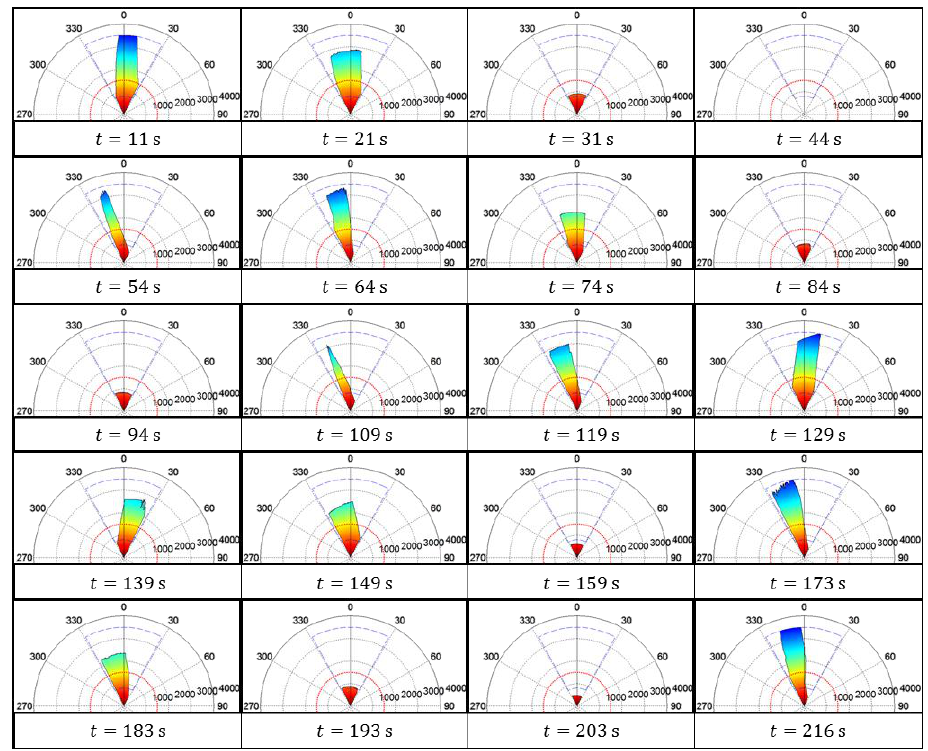
Figure 12. Depth information recorded in the form of polar space.